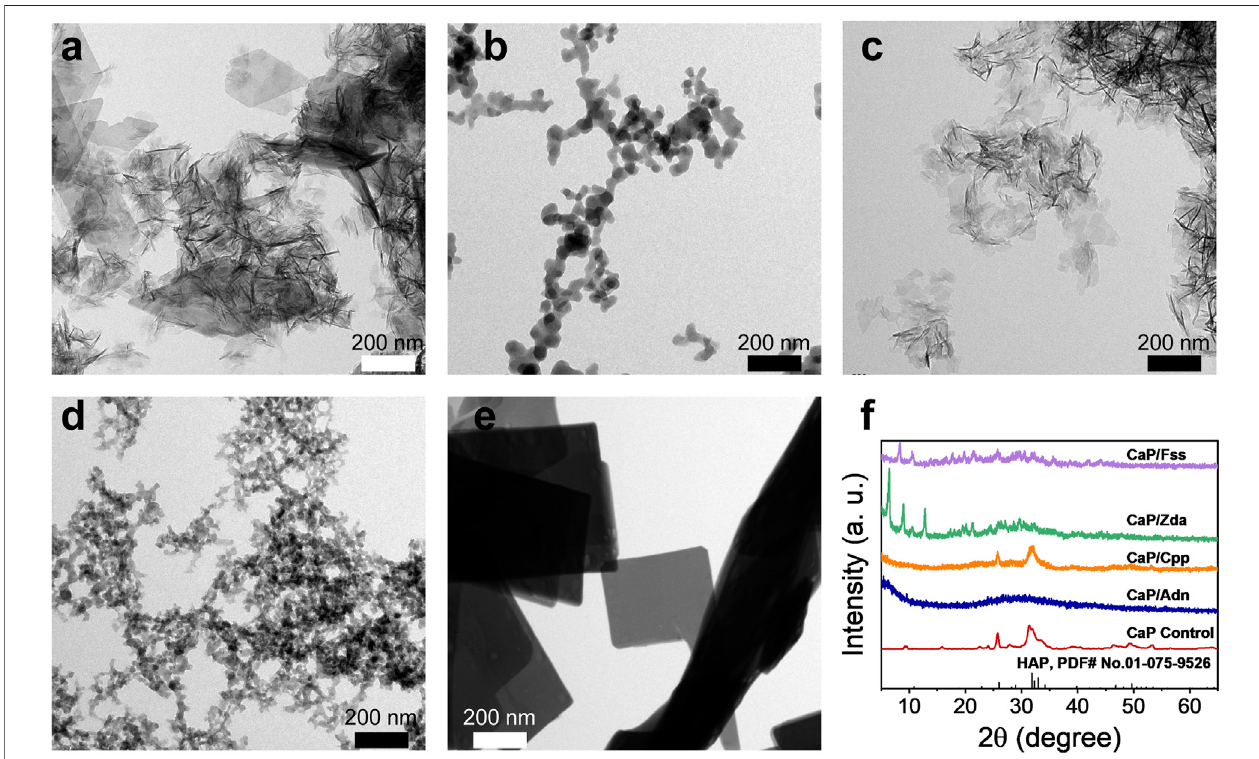
FIGURE 3 | TEM micrographs of (A) CaP Control, (B) CaP/Adn, (C) CaP/Cpp, (D) CaP/Zda, and (E) CaP/Fss; (F) XRD patterns of CaP Control, CaP/Adn, CaP/ Cpp, CaP/Zda, and CaP/Fss products.